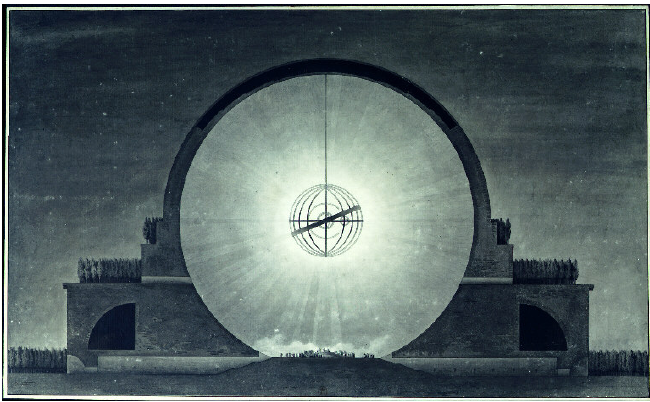
Figure 1. Étienne-Louis Boullée, Cenotaph to Newton 1784. The space is understood as autonomous of its context. During the night it would be illuminated as though it were day. Conversely, during the day, small apertures in the dome appeared like the night